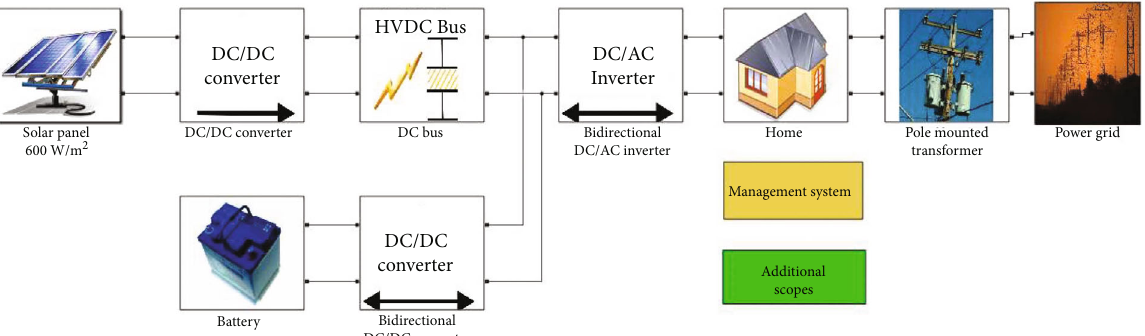
Figure 4: Simulation of the proposed system.